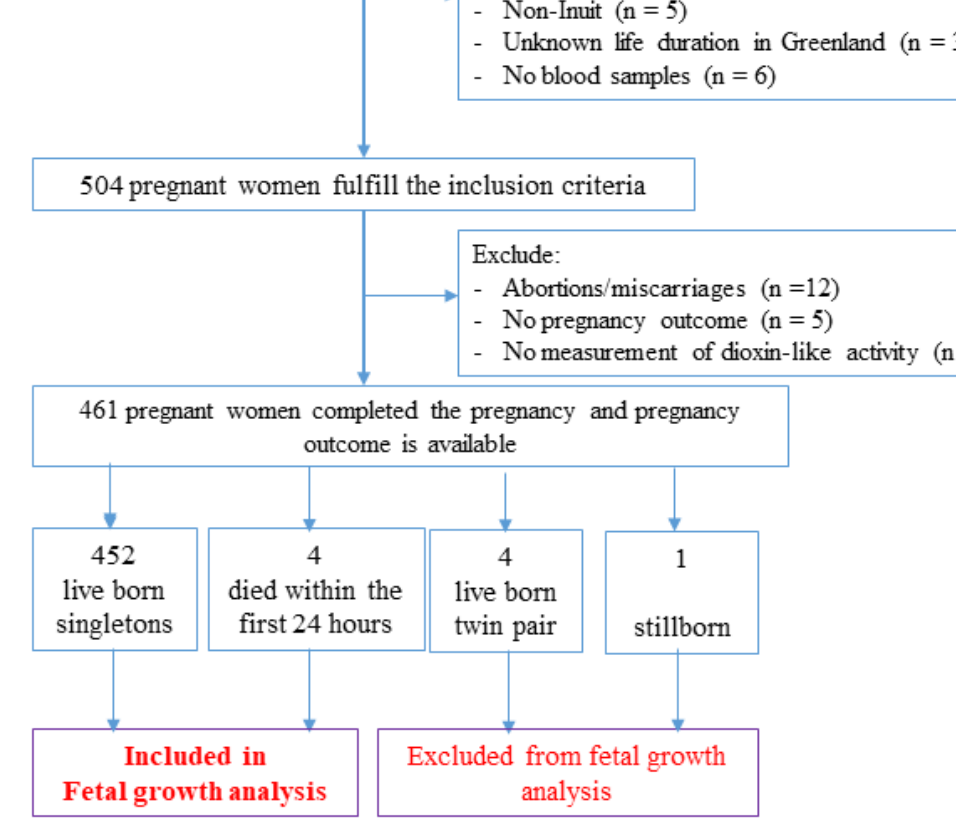
Figure 2. Flowchart for inclusion of study participants.